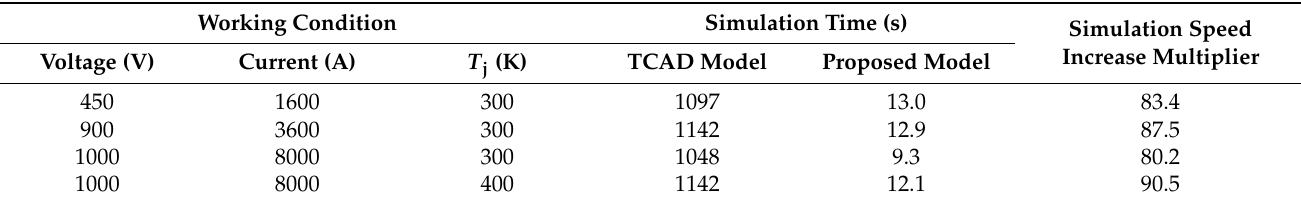
Table 5. Comparison of high current turn-off simulation